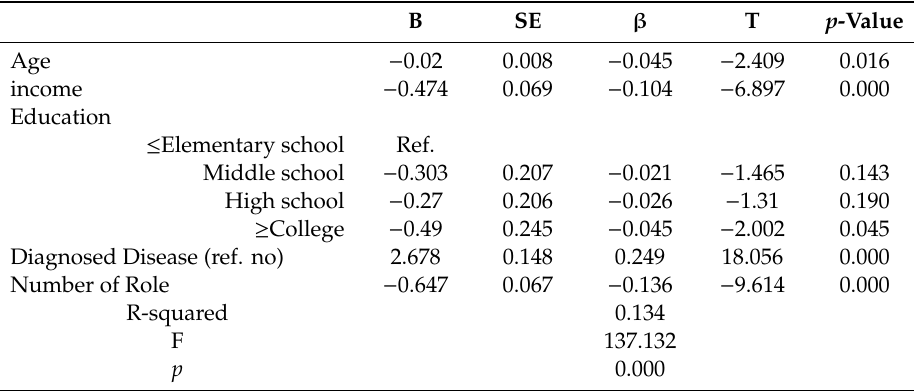
Table 3. E ff ects of the number of roles on depressive symptoms.